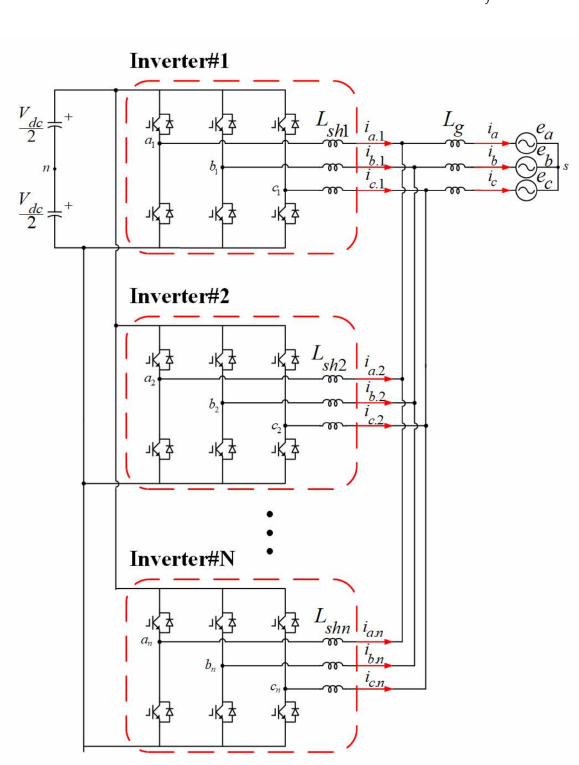
Figure 1. N-Parallel connected inverters